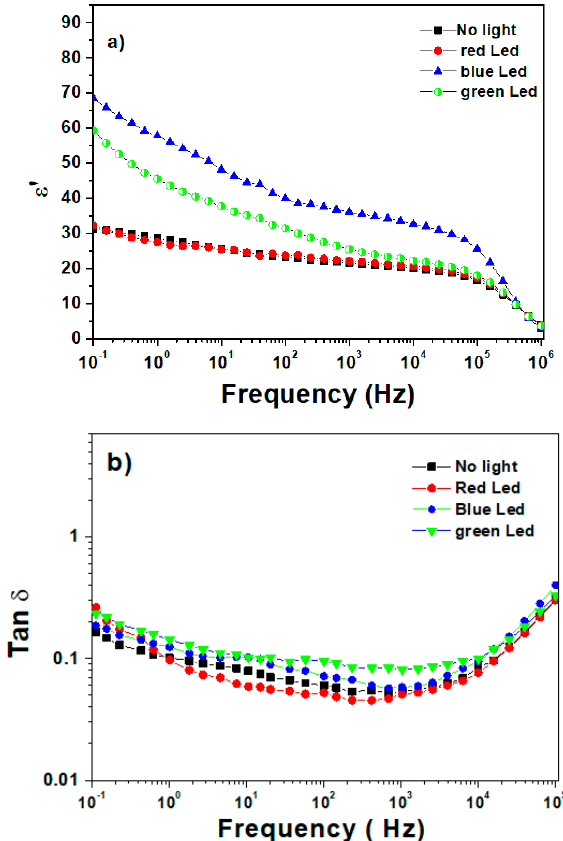
Figure 3. Frequency dependence at various LED lights of ( a ) the real part of complex permittivity and ( b ) the dissipation factor.